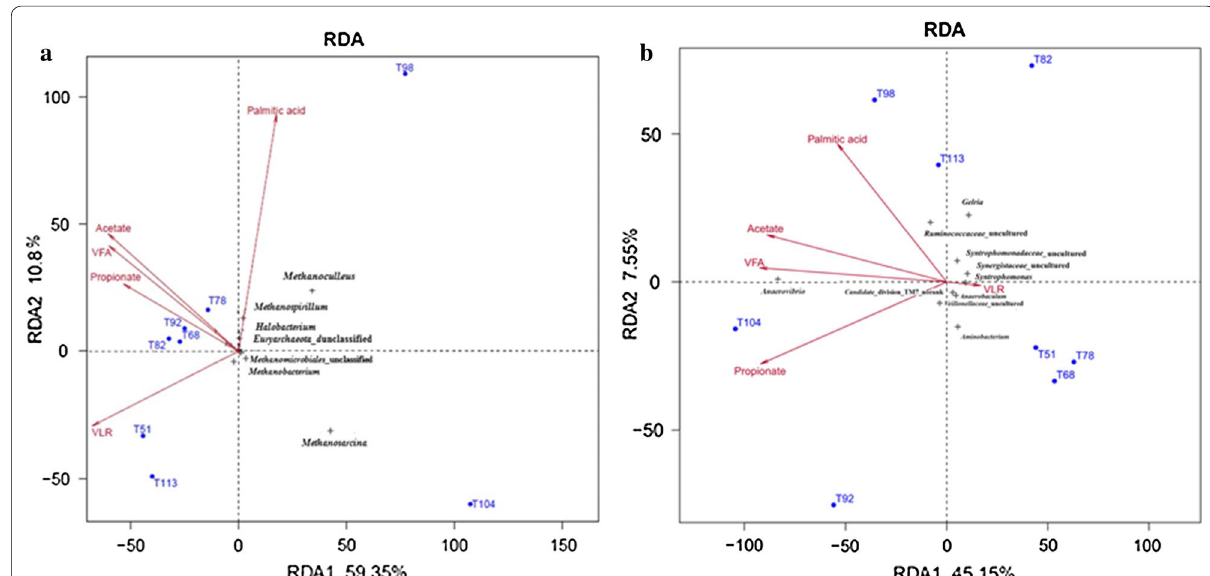
Fig. 5 Triplots of RDA ordination diagrams of TOP10 archaeal community ( a ) and TOP10 bacterial community ( b ) with total VFA, acetate, propionate, palmitic acid and volumetric organic loading rate (here VLR =